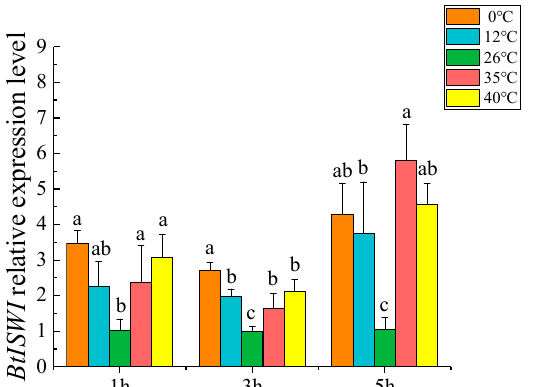
Figure 5. Relative expression levels of MEAM1 BtISWI after exposure to different temperatures. BtISWI mRNA expression was significantly up-regulated (except for exposure to 12 °C for 1 h) after exposure to heat shock and cold shock compared to the controls (26 °C, and the BtISWI mRNA expression at this temperature was stable all the time). The relative expression levels are expressed as the mean ±SEM. Bars with different lowercase letters are significantly different at p < 0.05.